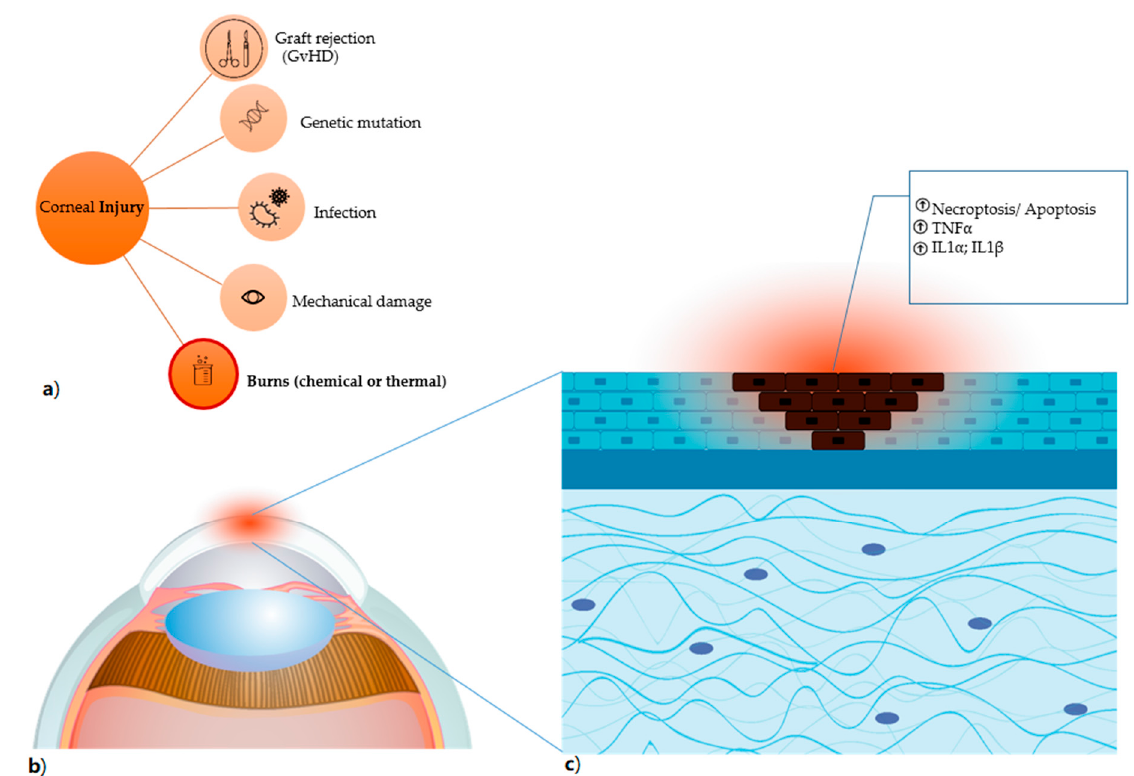
Figure 2. Corneal injury ( a ) the different types of corneal damages are listed, in particular burns, which comprise both chemical (for instance, induced by alkali exposure) and thermal burns. ( b ) Anatomical detail of the damaged corneal area, highlighted in red. ( c ) the damage caused by alkali burn induces necroptosis and apoptosis (shown as dark cells) with result in the release of factors that trigger the inflammatory process and have TNF α , IL1 α and IL1 β as primum movens.